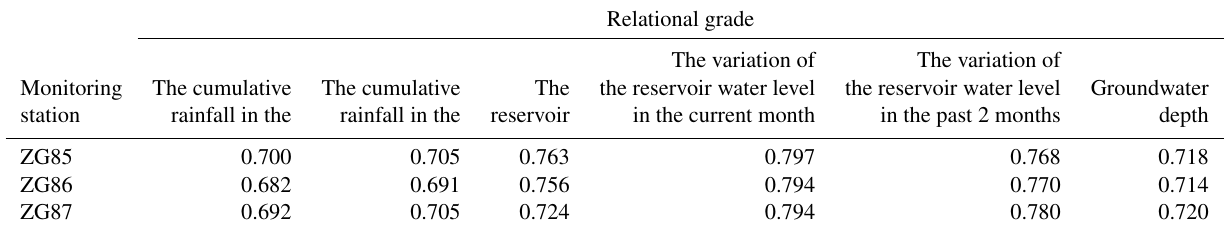
Table 1. Relational grades between input variables and the periodic displacements. Relational grade The variation of The variation of Monitoring The cumulative The cumulative The the reservoir water level the reservoir water level Groundwater station rainfall in the rainfall in the reservoir in the current month in the past 2 months depth ZG85 0.700 0.705 0.763